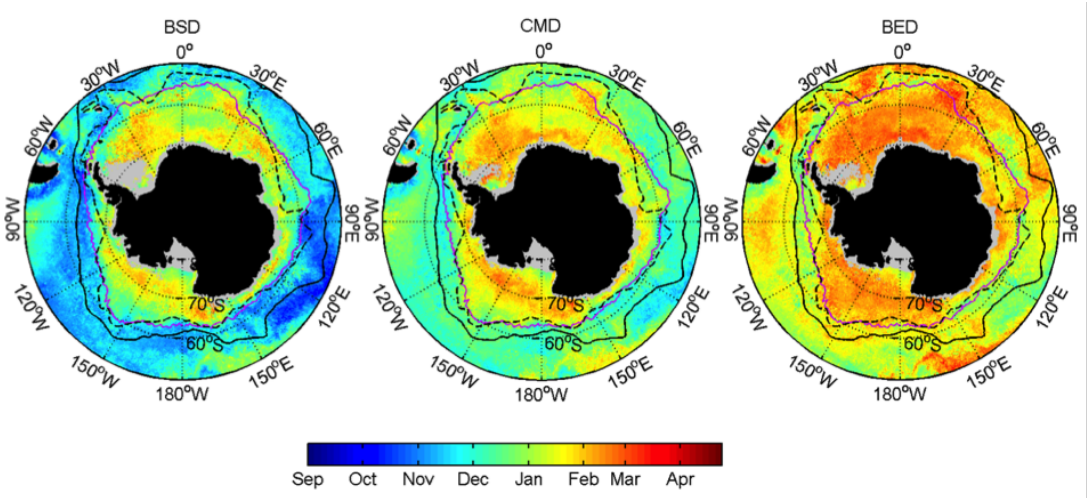
Figure 3. Spatial distribution of the mean diatom phenology in 1997–2012: ( left ) bloom start date–BSD, ( center ) date of Dia-Chla maximum–CMD, ( right ) bloom end date–BED. Grey areas represent missing data. Black solid lines show the mean position of the Polar Front [43] over 1997–2012. Dashed lines show the Southern Antarctic Circumpolar Front [44]. Purple line displays the median position of the maximum sea ice extent over 1997–2012